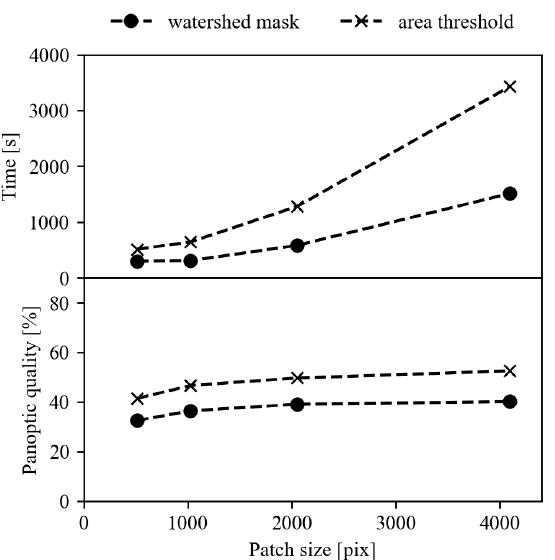
Figure 7. Influence of patch size and roof mask usage in the closed shape extraction step on computa- tion time and final